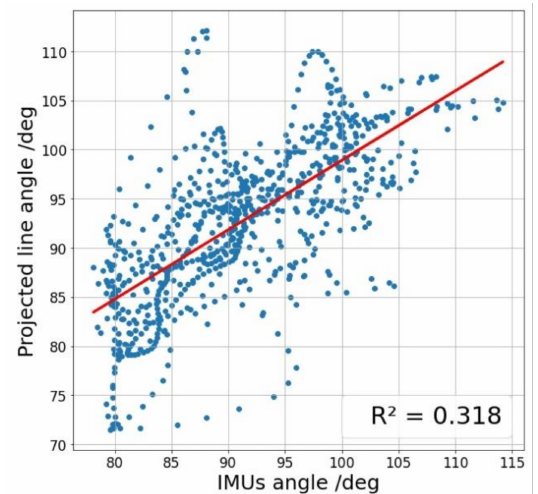
Figure 18. Graph showing the linearity between the ankle angle measured by the Kinect v2 with our method of projection lines and the angle measured by the IMUs using Euler’s angles, for different a walking test between 5 and 1